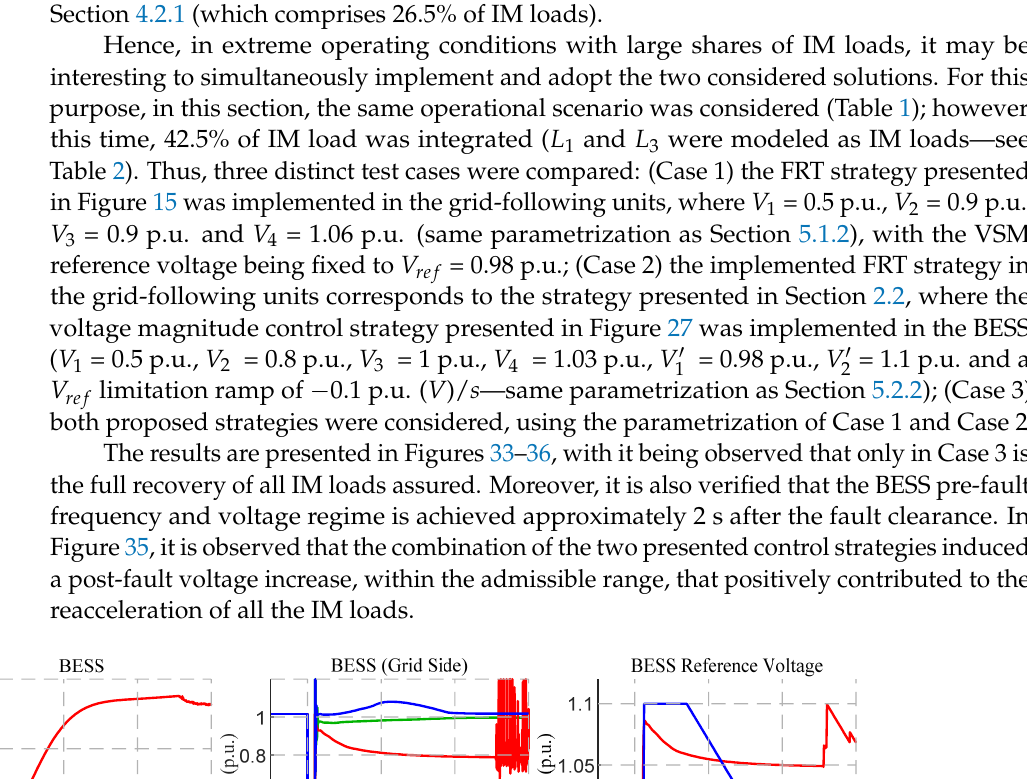
Figure 35. WF1 reactive current output and terminal voltage. 0